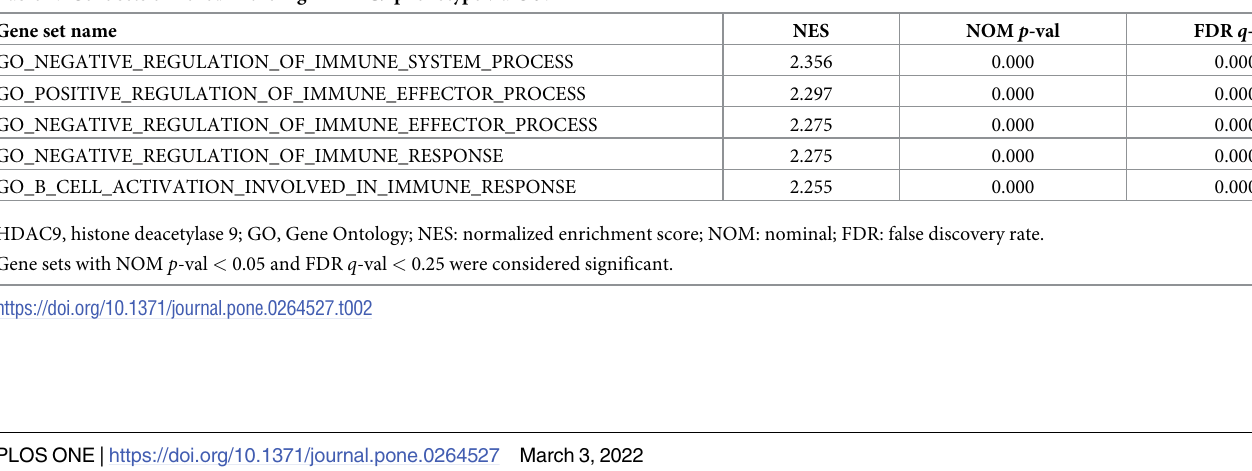
Table 2. Gene sets enriched in the high HDAC9 phenotype via